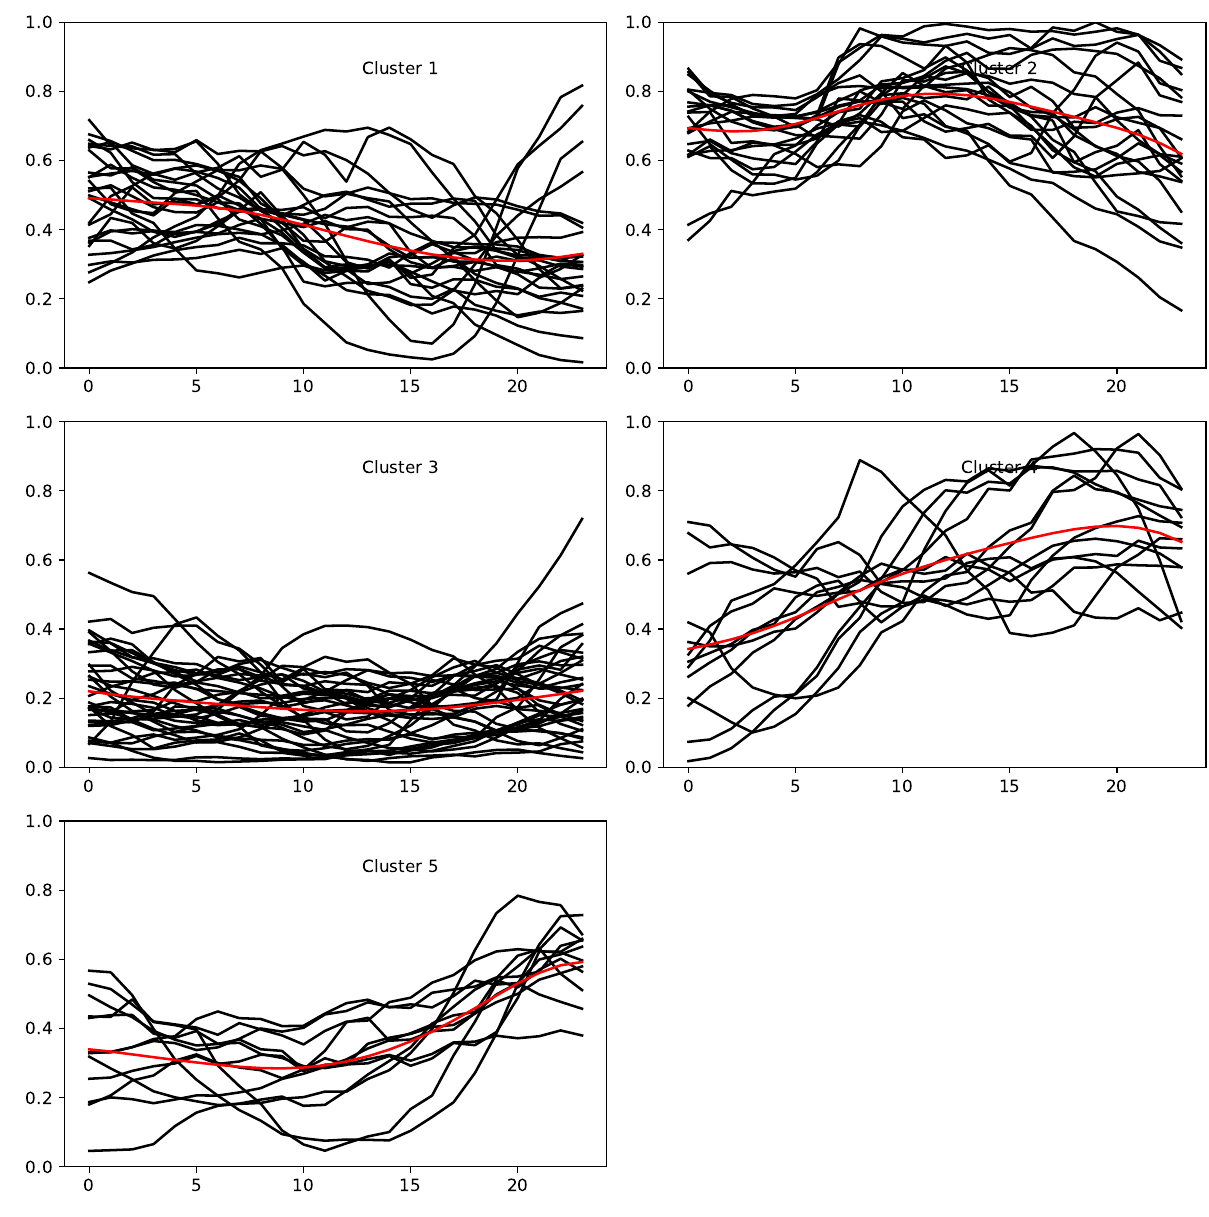
Figure A4. Season 1 wind generation data